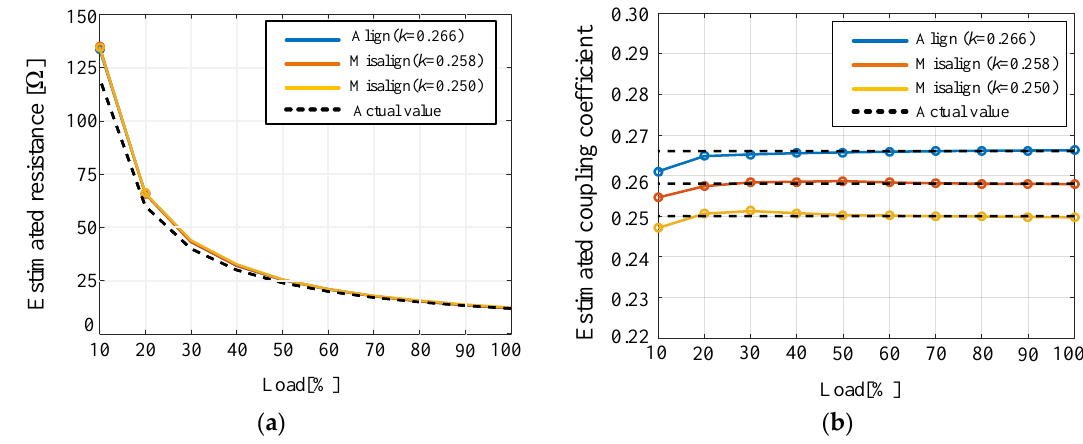
Figure 7. The estimated value of ( a ) R L and ( b ) k according to load and alignment condition.